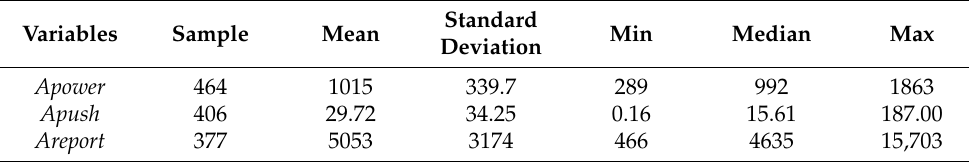
Table 2. Descriptive statistics of government environmental auditing variables.